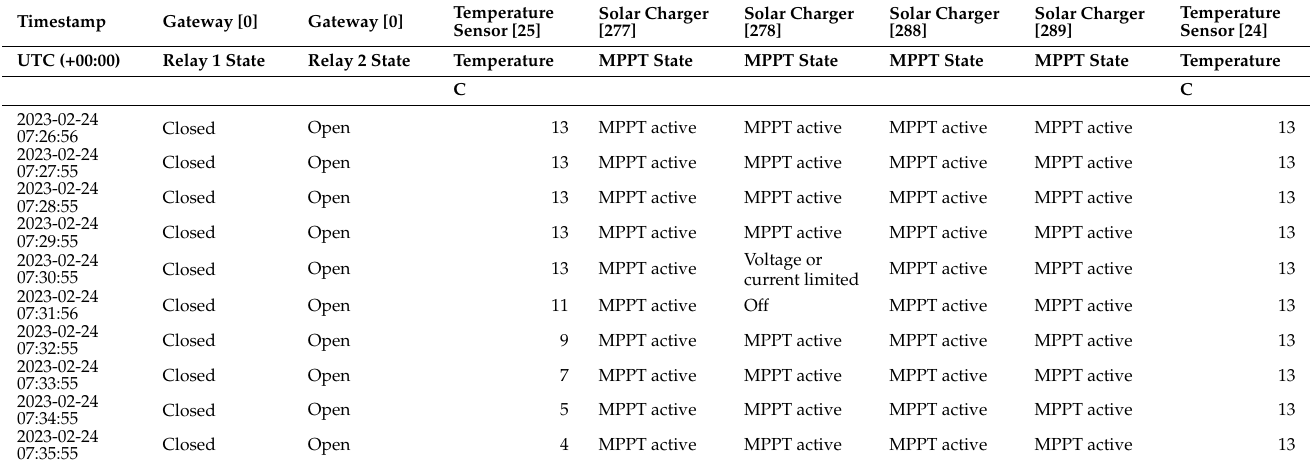
Table 8. Capture in test based on low-temperature alarms in the inverter using Temperature Sensor 25, acting on Relay